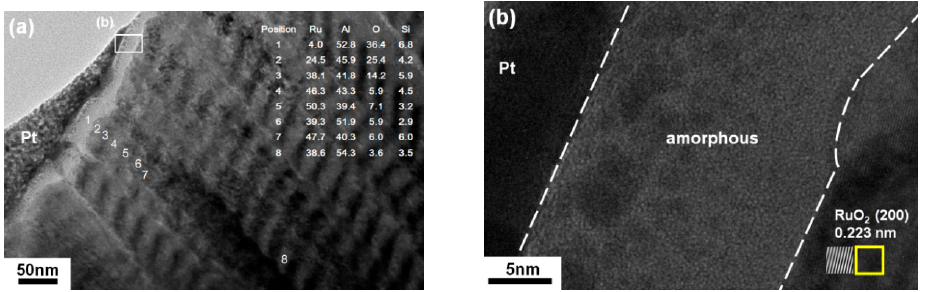
Figure 7. ( a ) Cross-sectional transmission electron microscopy (TEM) image and ( b ) high-resolution TEM image of the Ru 0.48 Al 0.52 thin films annealed in 1% O 2 –99% Ar at 600 °C for 24 h.